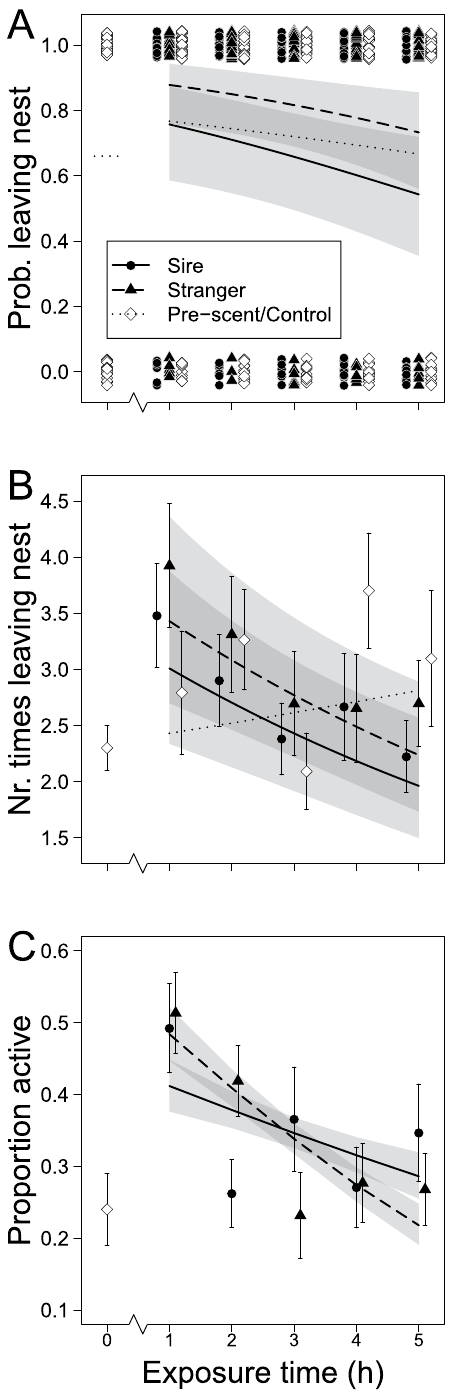
Figure 1. Effects of scent treatment and exposure time on behaviour of 35 lactating, non-pregnant bank vole ( Myodes glareolus ) females, following the spread of the scent of their litter’s sire (Sire; circles), of an unfamiliar male (Stranger; triangles), and of scentless cage bedding (Control; diamonds); and behaviour during the hour prior to spread (exposure time = 0, Pre-scent): ( A ) probability to leave the nest, ( B ) number of times leaving the nest, and ( C ) proportion of time spent active (for a subset of 22 females). Model predictions (lines: Sire continuous, Stranger dashed, Control dotted) and 95% confidence intervals (shaded areas; excluding Control) for time after exposure are